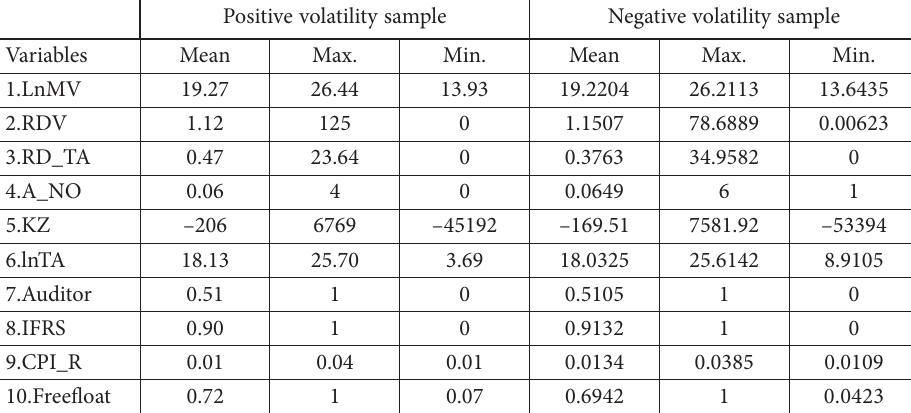
Table 2. Descriptive statistics (positive and negative volatility